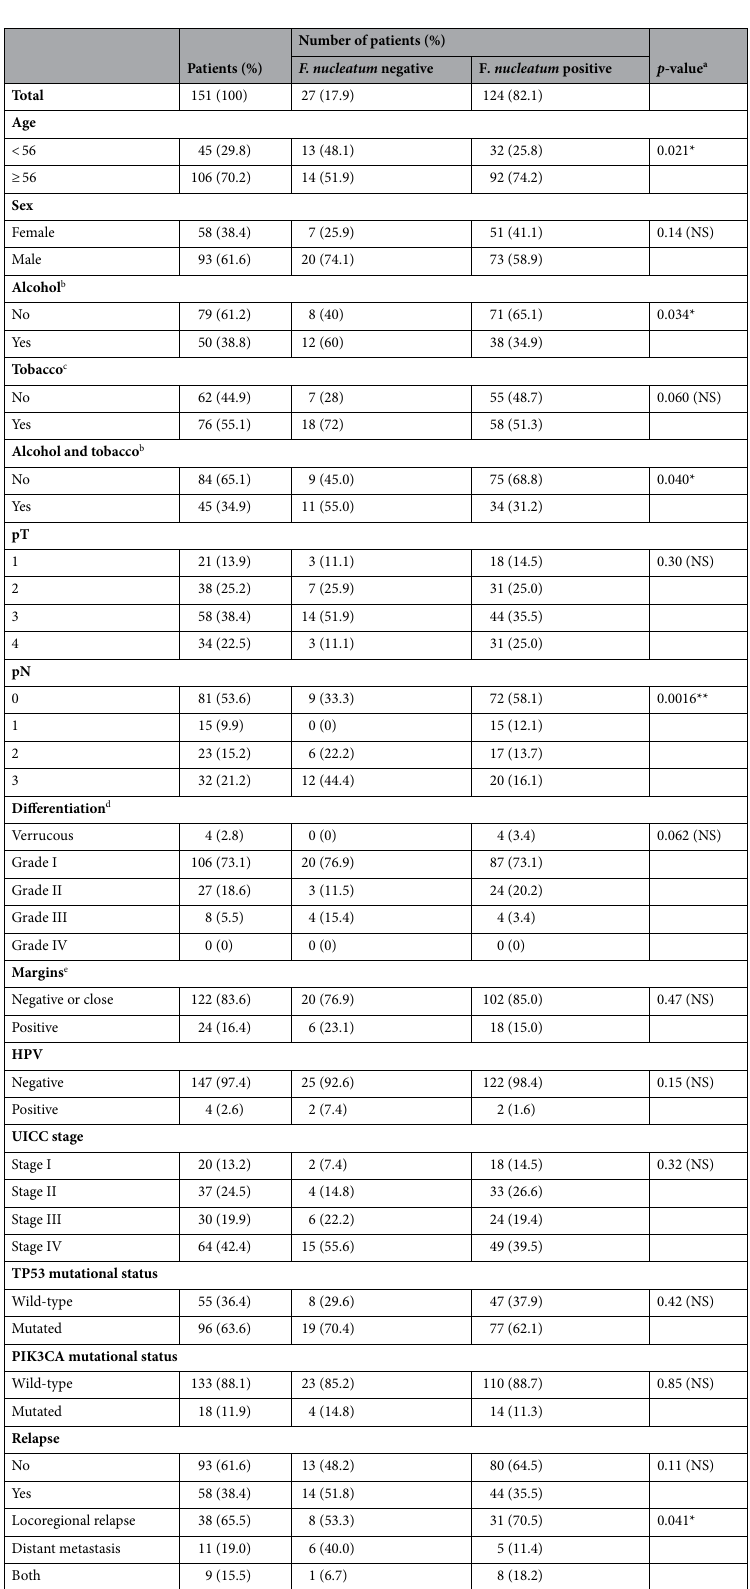
Table 2. Relationship between F. nucleatum status and clinical, biological and pathological characteristics of the 151 patients of the merged cohort. HPV human papilloma virus, UICC Union for international cancer control, NS Not significant. * p < 0.05. ** p < 0.01. *** p < 0.001. a Chi-square test, Chi-square test with Yates’ correction or Fisher test if appropriate. b Information available for 129 patients. c Information available for 138 patients. d Information available for 145 patients. e Information available for 146